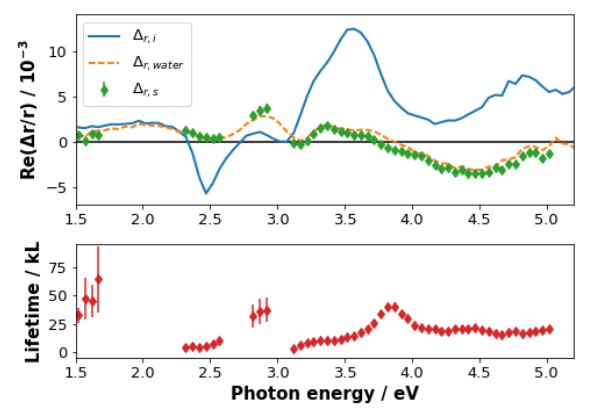
Figure 7: RA spectrum of heteroepitaxial GaPN / Si (2 ◦ off-cut) before (blue) and after (orange, dashed) the 77 kL H O, together with the saturation values from the 2 fits (green). The lower part of the plot shows the corresponding